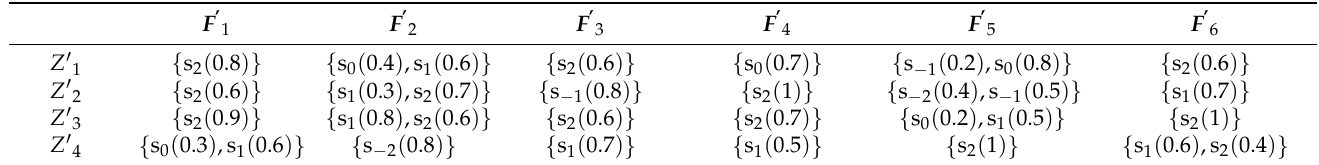
Table 1. The evaluation values by PLS